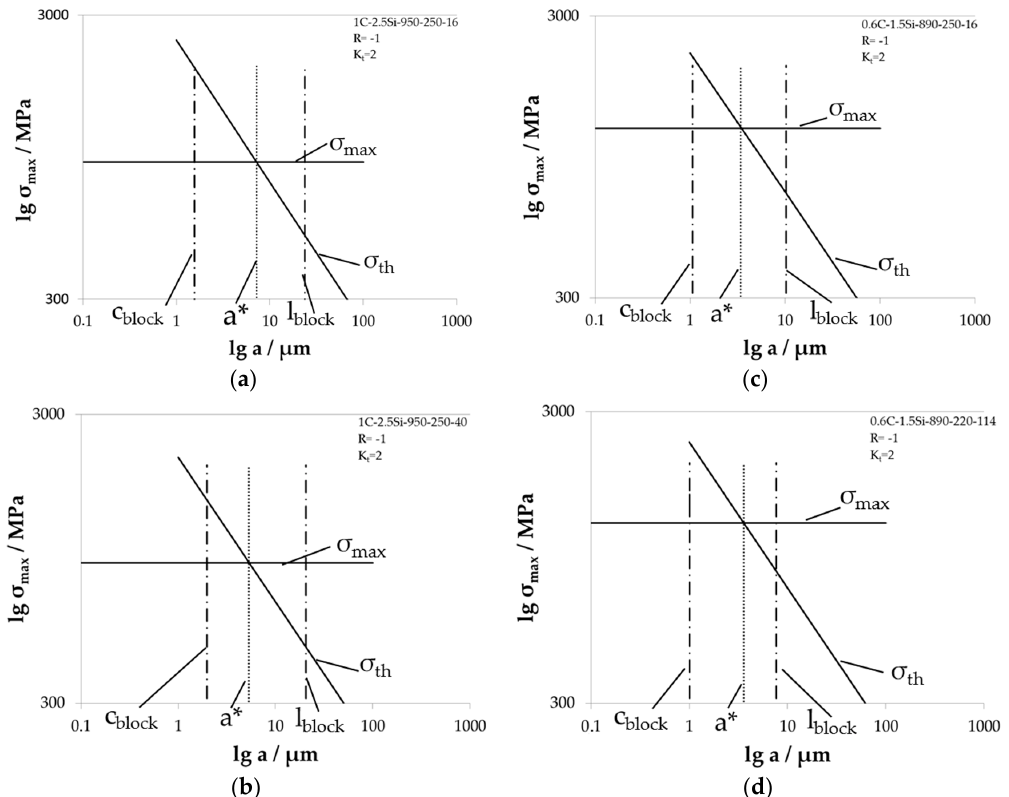
Figure 15. Individual Kitagawa diagrams for material states tested with load ratio R = 0.1 at notched specimens with K t = 4 for ( a ) 1C-2.5Si-950-250-16; ( b ) 1C-2.5Si-950-250-40; ( c ) 06C-1.5Si-890-250-16; and ( d ) 0.6C-1.5Si-890-220-114.